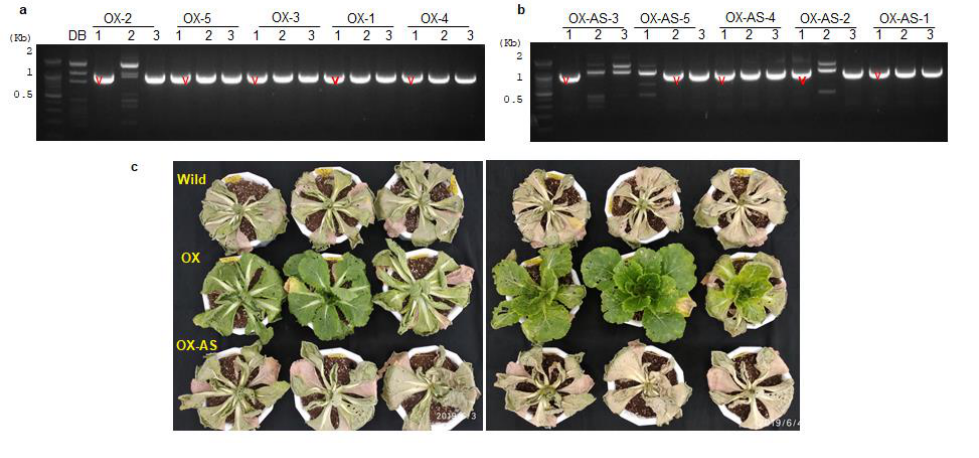
Figure 4. Transgene expression in transgenic B. rapa lines and their drought phenotypes. ( a , b ) represent the transgenic lines overexpressing BrEXLB1 sense (OX) and antisense transcripts (OX-AS) in B. rapa lines, while ( c ) represents the stay-green phenotypes of transgenic lines subjected to 10 days of consecutive drought stress followed by recovery. The red color marks in ( a , b ) indicate the transgenic lines, chosen for BrEXLB1 sequence